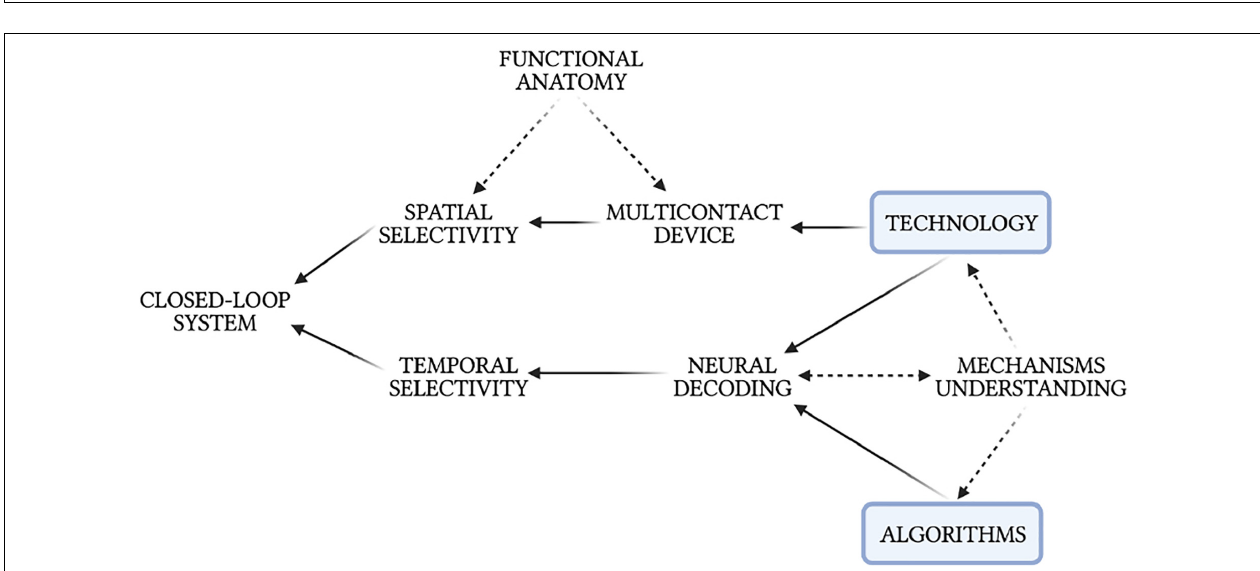
FIGURE 8 | Intercorrelations between neural decoding, technology, algorithms, physiological mechanisms, and the development of a closed-loop neuromodulation system.